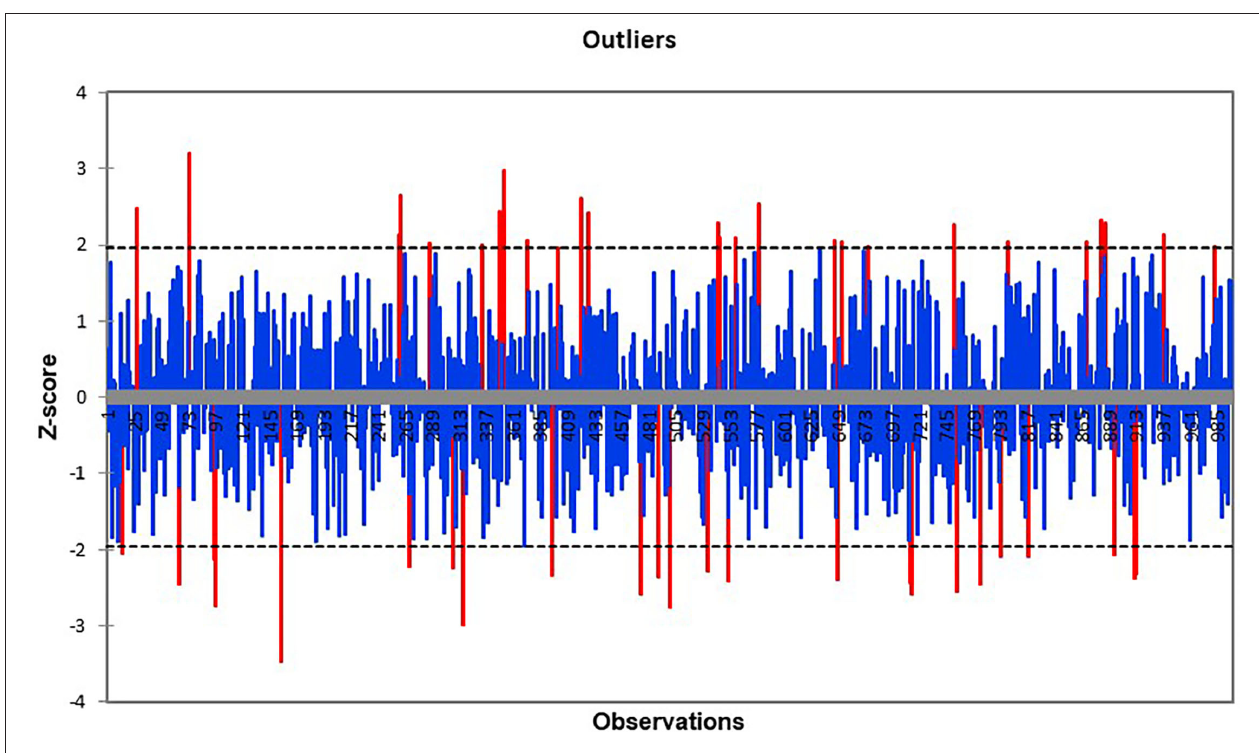
FIGURE 1 | Grubbs